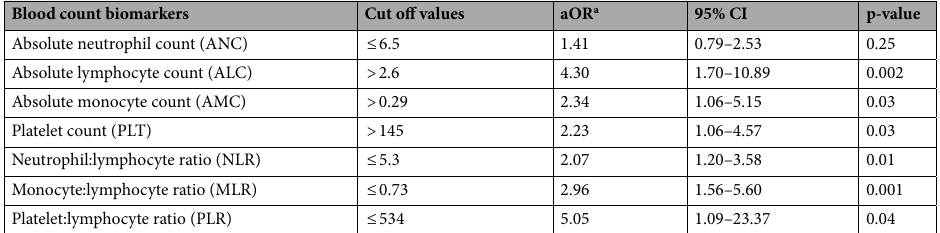
Table 4. Association between cut off values of blood count biomarkers and irAEs. a Adjusted for age, sex, smoking history, cancer type (hematological malignancy vs solid tumor), ECOG PS, concomitant other systemic therapy, personal or family history of autoimmune disease, personal history of chronic infection, systemic steroid treatment at time of ICI initiation.